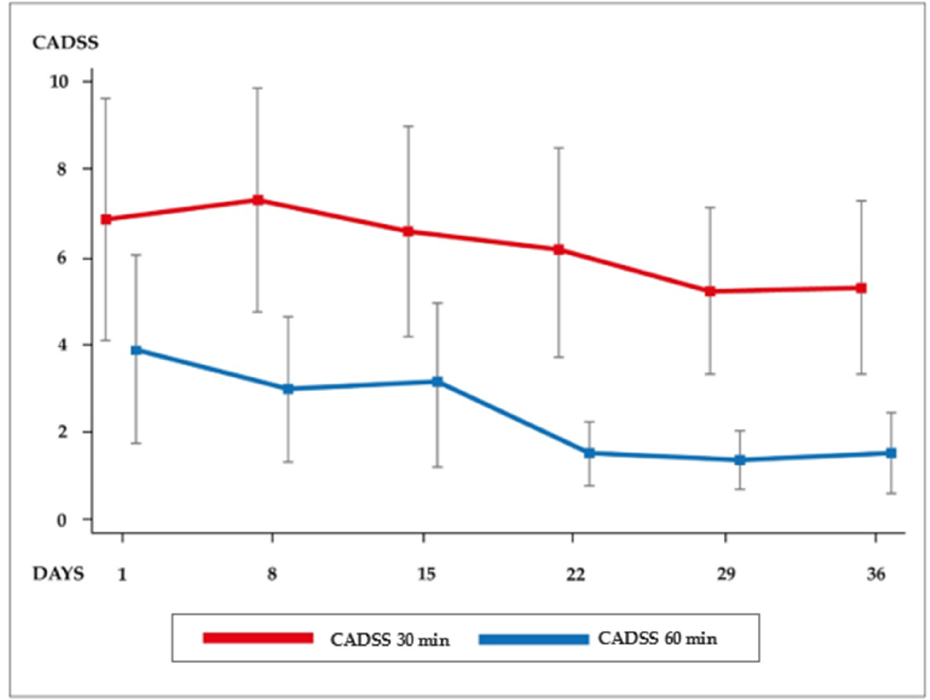
Figure 1. Mean CADSS scores 30 and 60 min after the infusions.